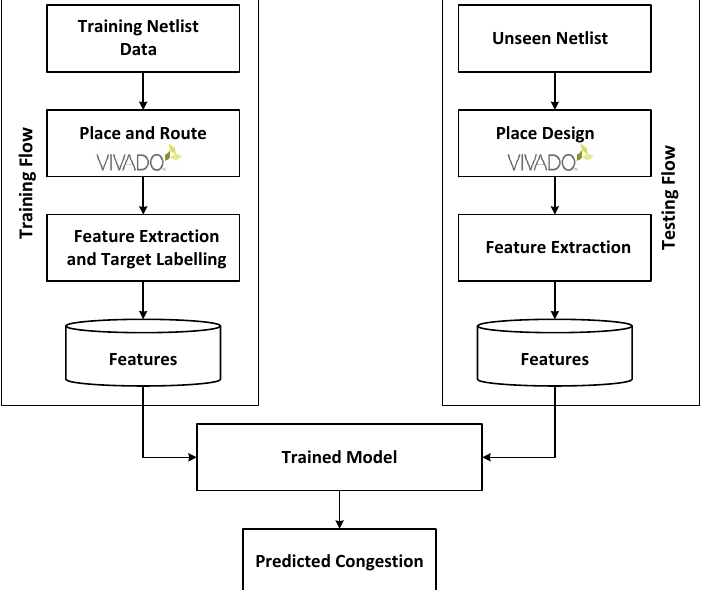
Figure 3. Design flow for congestion prediction model training and model-based congestion